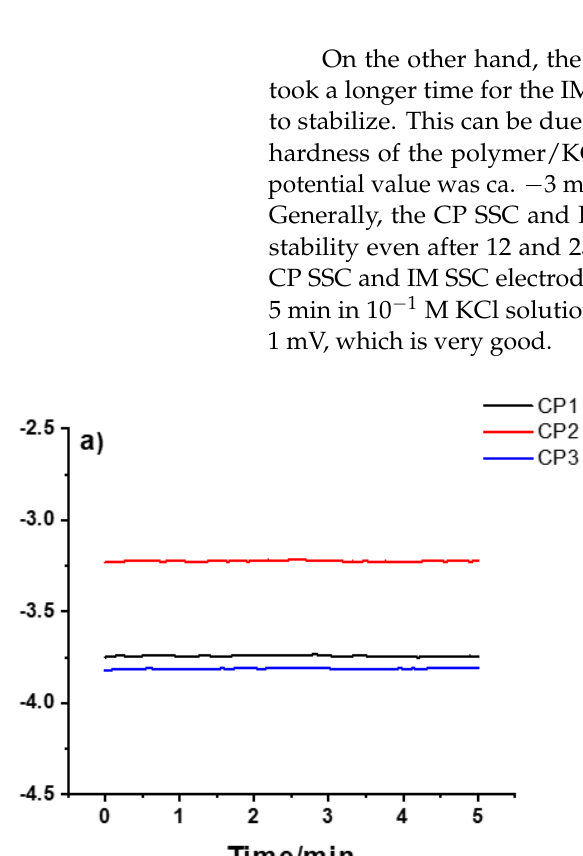
Figure 2. Reproducibility of the potential of ( a ) CP SSC and ( b ) IM SSC identical electrodes measured in 10 -1 M KCl solution.